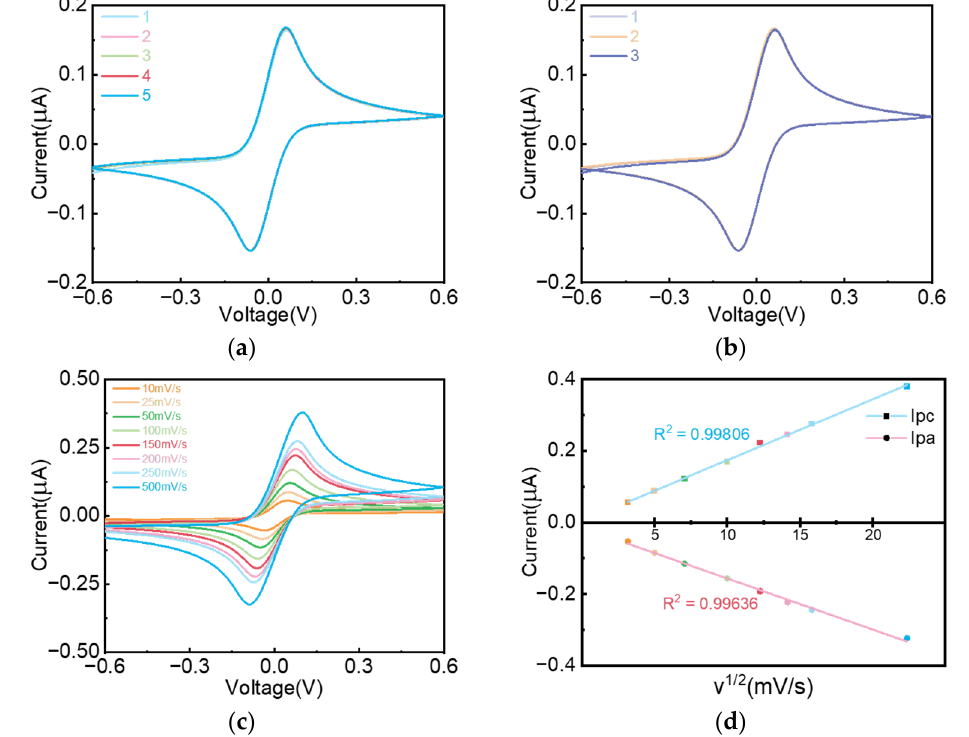
Figure 3. Performance characterization of electrochemical detection chip by cyclic voltammetry. ( a ) stability with five repeated measurements on the same electrode, ( b ) reproducibility with three independent electrodes, ( c ) reversibility with different scanning rates, ( d ) relationship of peak current with the square root of scan rate: cathodic curve (in blue), anodic curve (in pink).